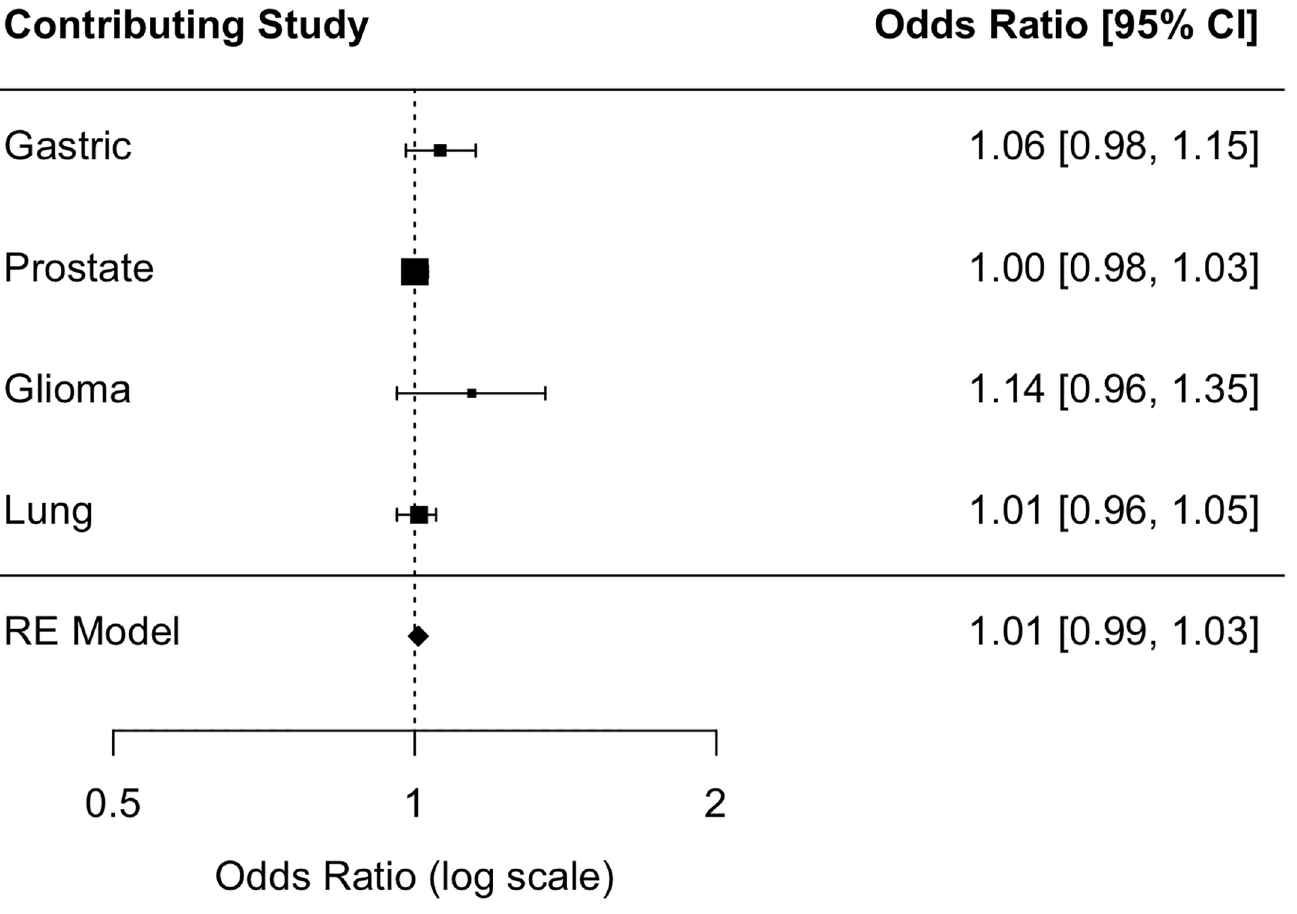
Fig 2. Association between a one-cup increase in coffee consumption and above-median telomere length. Fig 2 shows the individual study odds ratio (OR) estimates and the random-effects (RE) summary OR estimate of the association between a one-cup increase in coffee consumption and above-median relative telomere length among study